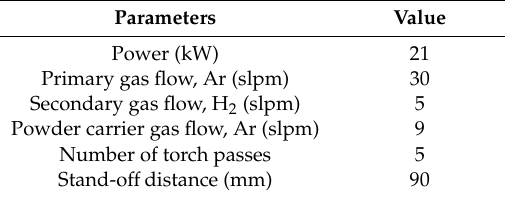
Table 1. Setup parameters for plasma coating of Sr–HT–G and HAp